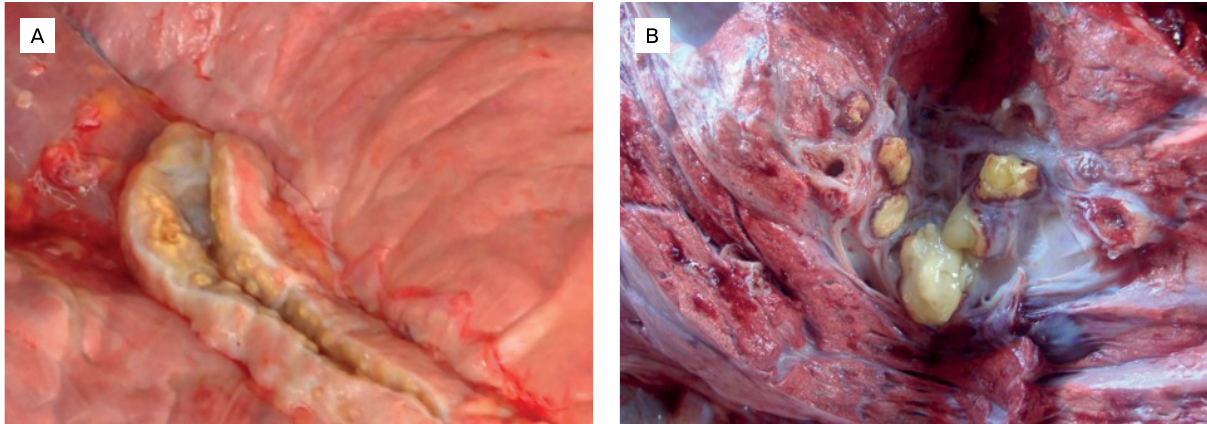
Figure 1. (A) Mediastinal lymph node showing caseous nodules. (B) Lung with disseminated caseous nodules of varying size and